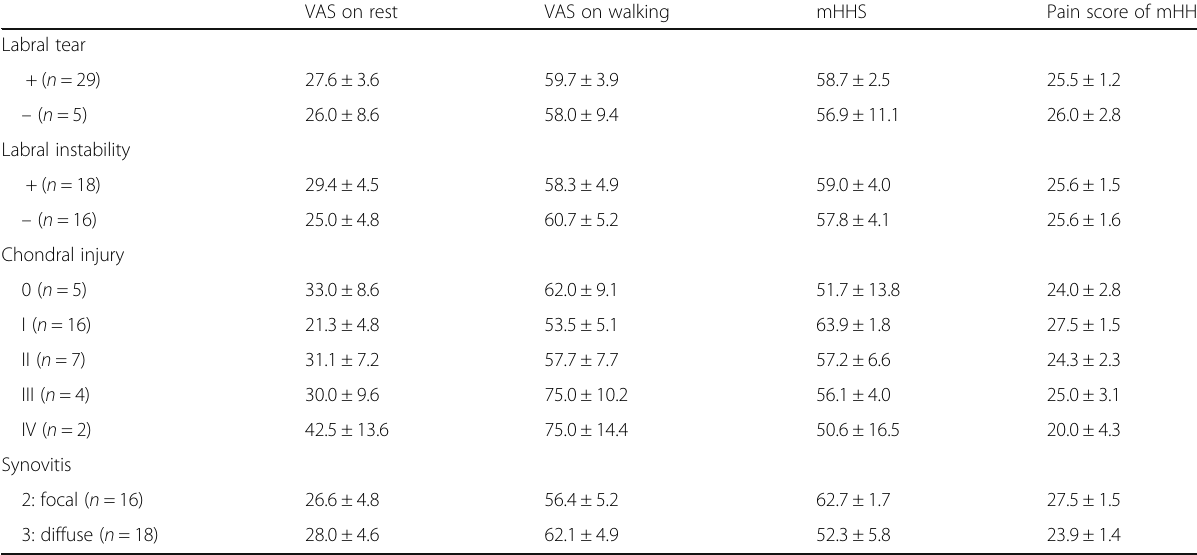
Table 2 Comparison of pain severity in patients classified by arthroscopic findings VAS on rest VAS on walking mHHS